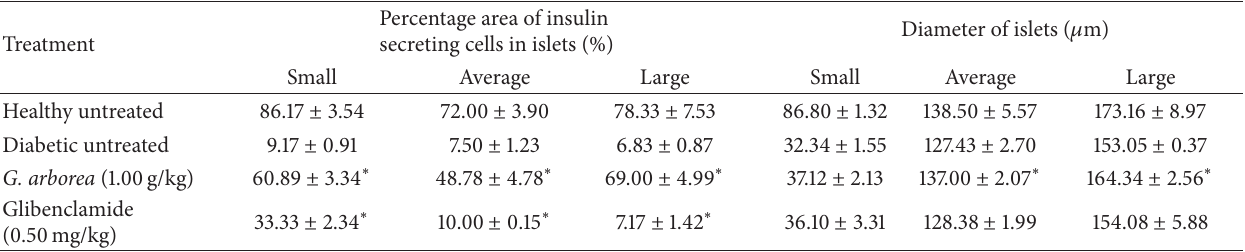
Table 4: Effect of plant extracts on percentage of insulin secreting 𝛽 -cells and diameter of islets in the pancreas of streptozotocin induced diabetic rats after 30 days of treatment.